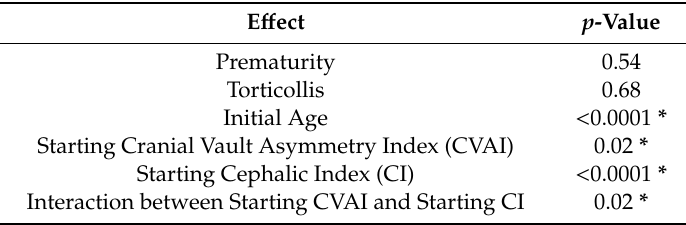
Figure 3. Receiver operating characteristic (ROC) curve for a model with all factors. Factors are: initial cephalic index (CI), initial cranial vault asymmetry index (CVAI), interaction between initial CI and CVAI, initial age, prematurity, and torticollis). The area under the curve is 0.89. Table 4. Analysis of e ff ects for Figure